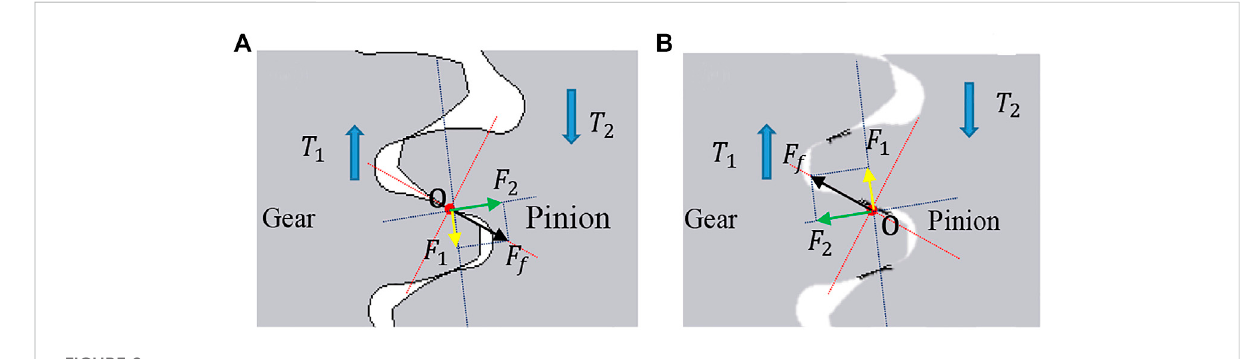
FIGURE 2 Force analysis. (A) Early engagement and (B) Late